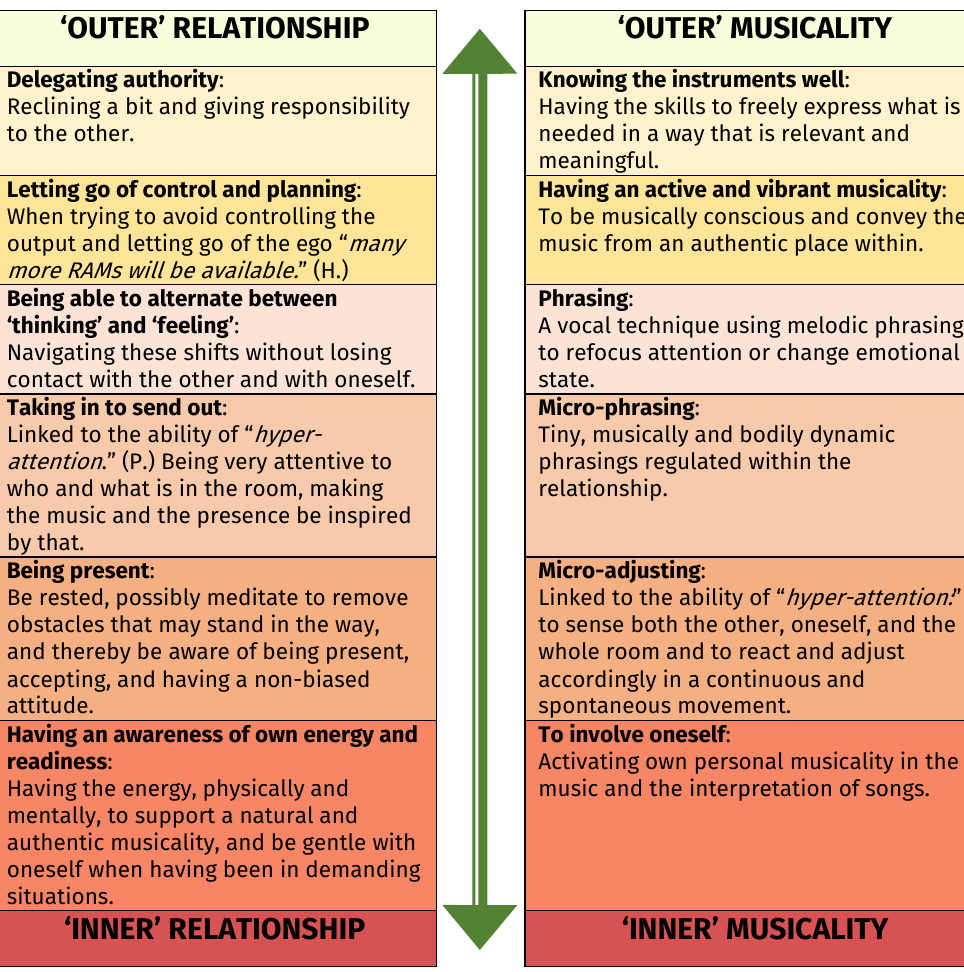
Figure 1.2. Possible Stepping Stones Towards Authenticity